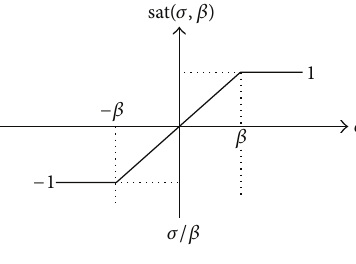
Figure 4: Sliding layer concept.